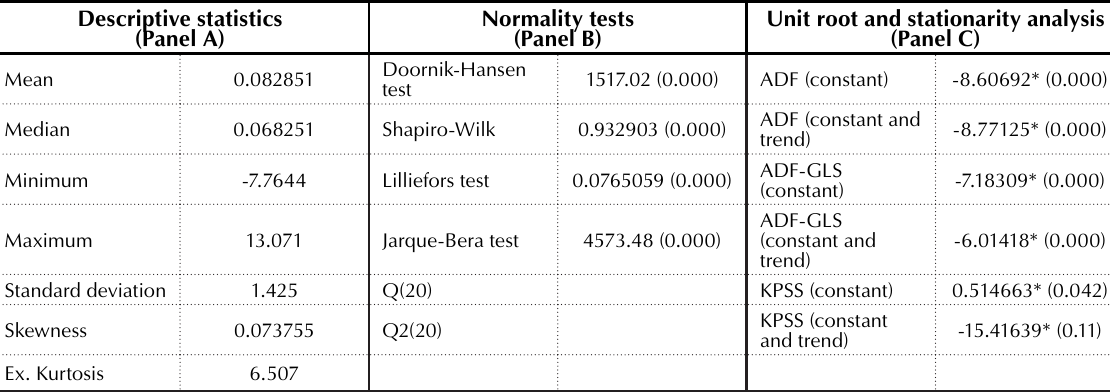
Table 1. Descriptive statistics and stationarity